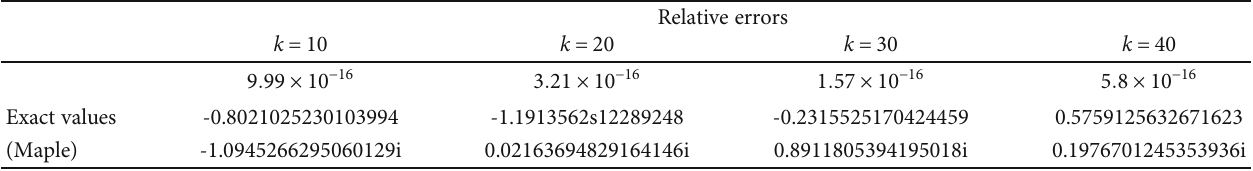
Table 5: Relative errors of the direct steepest descent method for . Relative errors k =